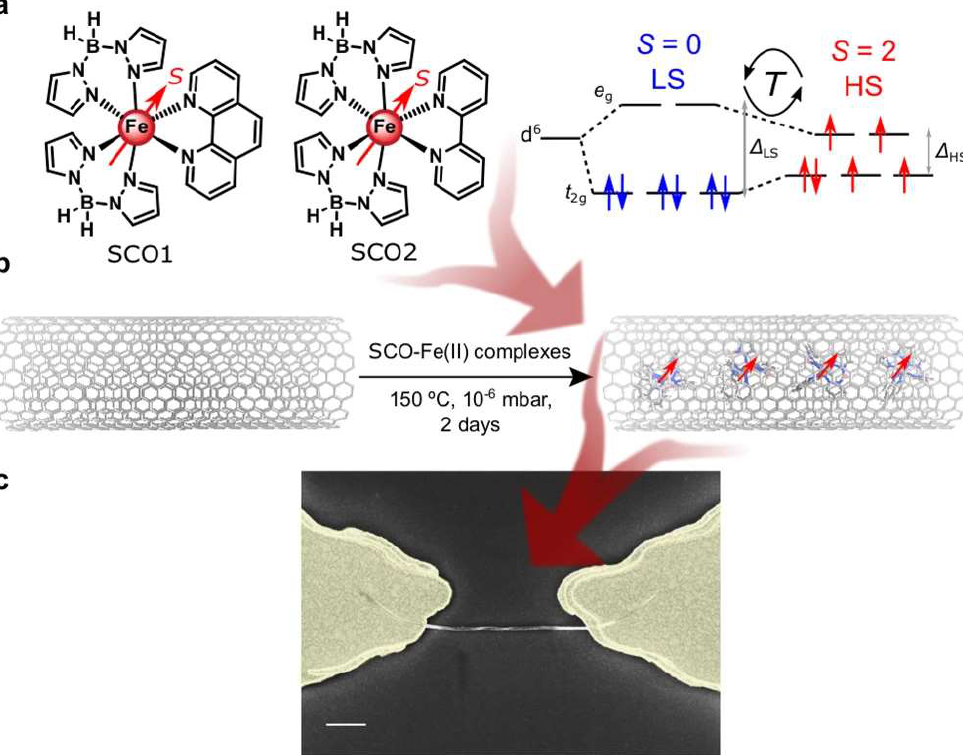
Figure 5. ( a ) Complex SCO1, [Fe(H 2 Bpz 2 ) 2 (phen)] and SCO2, [Fe(H 2 Bpz 2 ) 2 (bipy)] encapsulated in this work. Spin (S) level distribution in the high (HS) and low (LS) spin states of the molecules. ( b ) Schematic pathway for the encapsulation of Fe (II) SCO complexes in oSWCNTs, resulting in SCO@SWCNT. ( c ) Scanning electron microscopy (SEM) image of a transistor-like device containing a SCO2@SWCNT heterostructure trapped via dielectrophoresis. Scale bar: 500 nm. Reproduced from ref [49] with permission of Nat. Commun . copyright 2021.